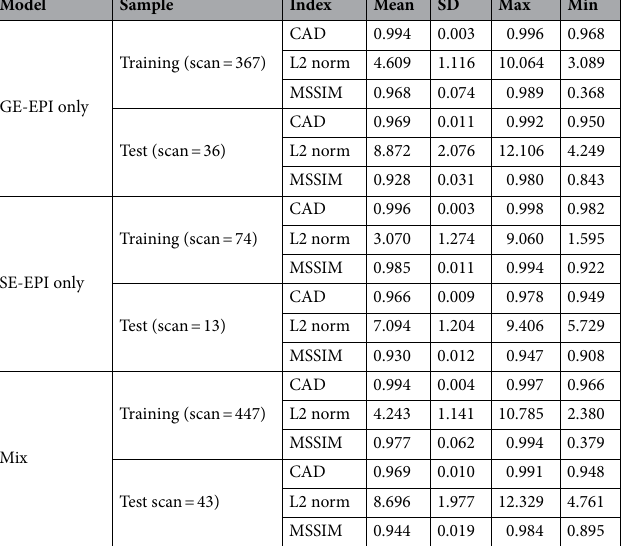
Table 1. Similarity indices of test data for each corresponding model. SD standard